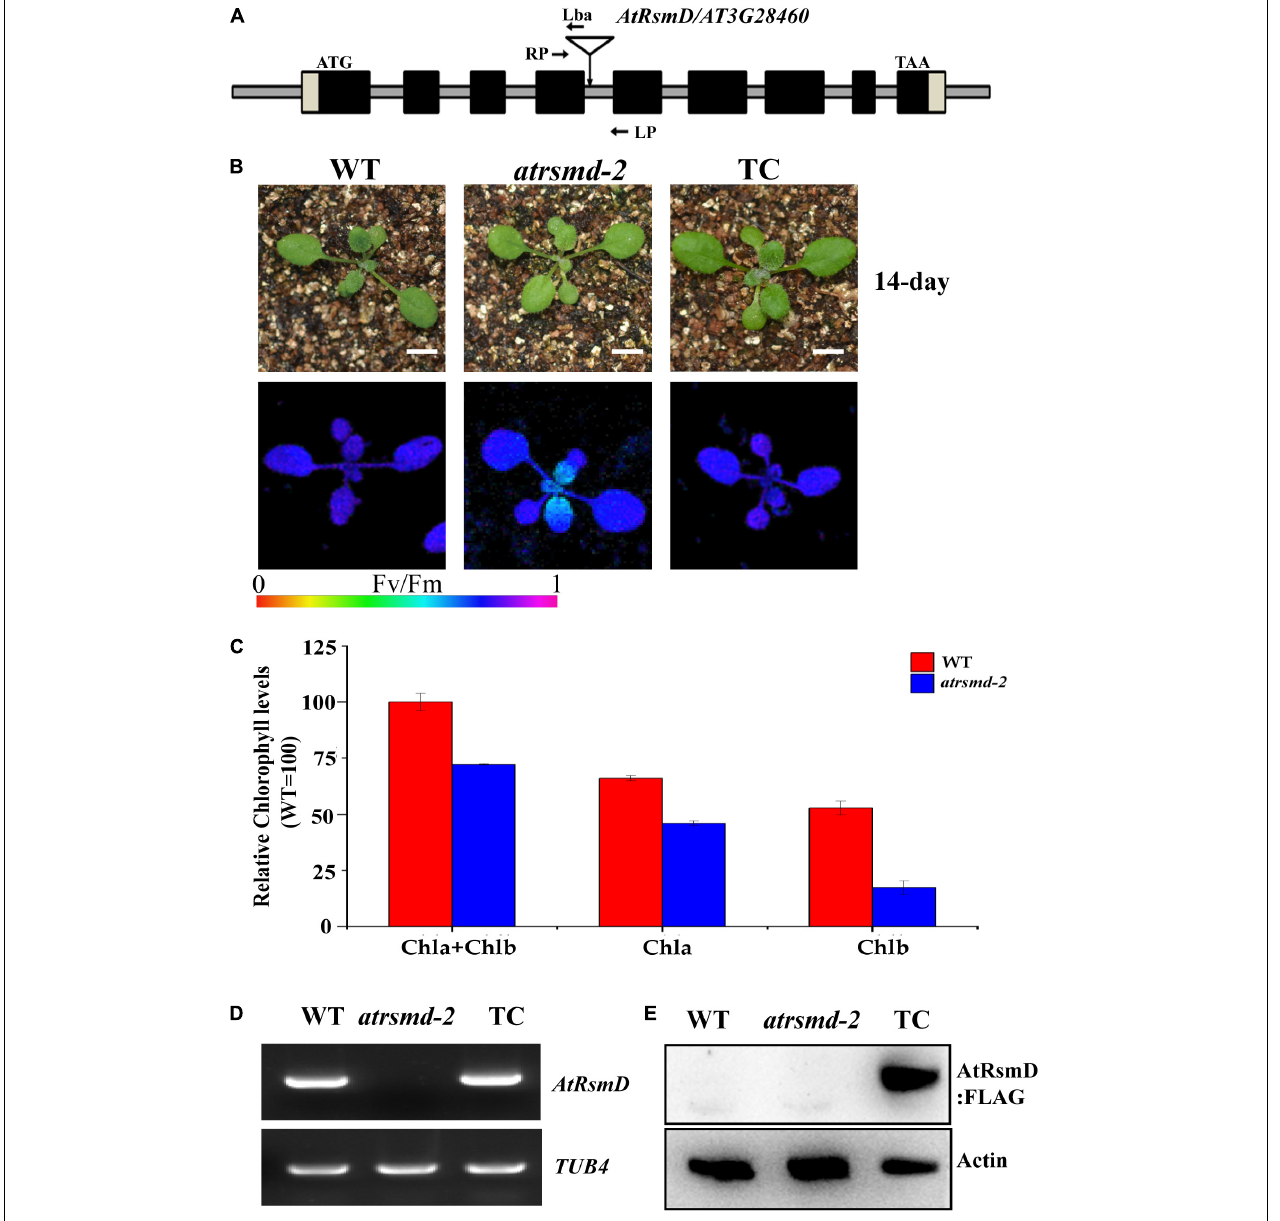
FIGURE 1 | Knockout of the AtRsmD gene impaired photosynthetic efficiency in Arabidopsis. (A) Schematic illustrating the genomic structures of AtRsmD and the location of the T-DNA insertion. Black boxes and striped boxes indicate exons and introns, respectively. The T-DNA insertion site is indicated by an inverted triangle. Lba represents the left border primer of the T-DNA insertion. LP and RP represent the left and right genomic primers around the T-DNA insertion site, respectively. (B) Phenotype and Fv/Fm values of 14-day-old seedlings the wild type (WT), atrsmd-2 mutant and complemented lines (TC). Bar represents 1 cm. (C) Chlorophyll content in the emerging leaves from the 14-day-old wild type and atrsmd-2 mutant seedlings. (D) RT–PCR analysis of the AtRsmD gene in the wild type, atrsmd-2 mutant, and complemented line (TC). Tubulin 4 was used as a control. (E) Immunoblotting analysis of AtRsmD:FLAG in the wild type, atrsmd-2 mutant, and complemented line (TC) with the anti-FLAG antibody. Actin was used as a